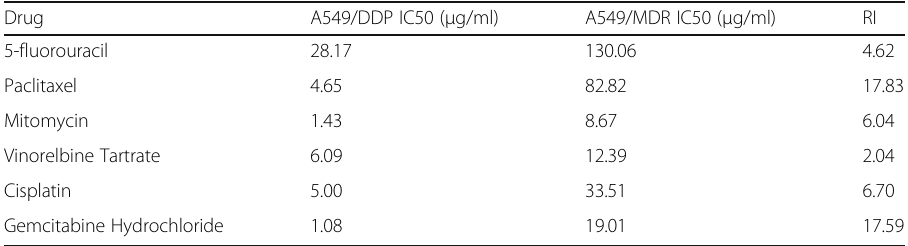
Table 1 Cytotoxicity of drugs in A549/DDP and A549/MDR cells Drug A549/DDP IC50 ( μ g/ml) A549/MDR IC50 ( μ